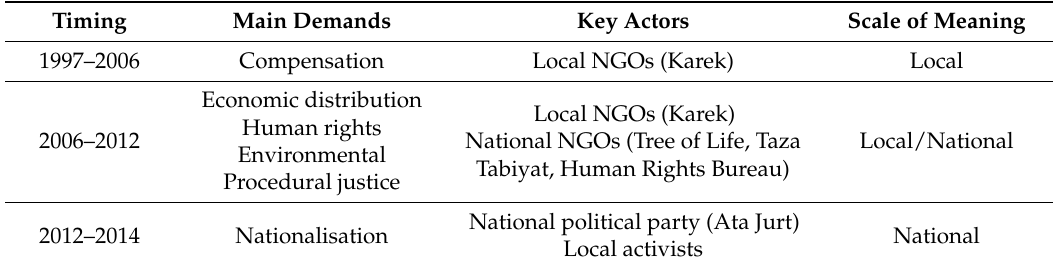
Table 3. Broad trajectory of the anti-Kumtor